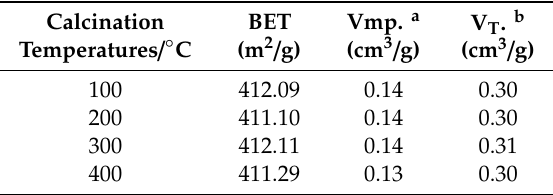
Table 1. Textural properties of 10 wt% NiP/H β calcined at different temperatures.